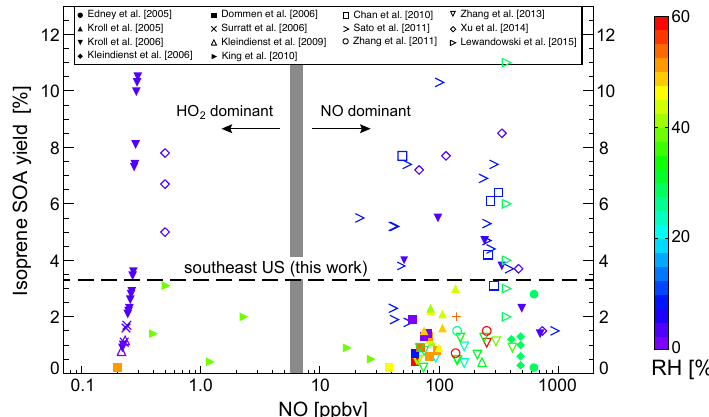
Figure 1. Yields of secondary organic aerosol (SOA) from isoprene oxidation as reported by chamber studies in the literature and plotted as a function of the initial NO concentration and relative humidity (RH). Yields are defined as the mass of SOA produced per unit mass of isoprene oxidized. For studies with no detectable NO we plot the NO concentration as half the reported instrument detection limit, and stagger points as needed for clarity. Data are colored by relative humidity (RH). The thick gray line divides the low-NO x and high-NO x pathways as determined by the fate of the ISOPO 2 radical (HO 2 dominant for the low-NO x pathway, NO dominant for the high-NO x pathway). The transition between the two pathways occurs at a higher NO concentration than in the atmosphere because HO 2 concentrations in the chambers are usually much higher. Also shown as a dashed line is the mean atmospheric yield of 3.3% for the southeast US determined in our